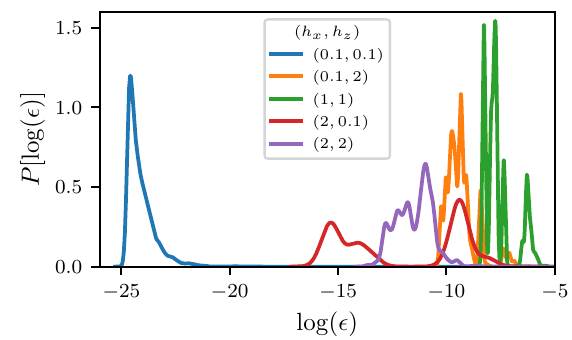
FIG. 4. Probability distribution function P [log ((cid:3)) ] of QAOA outcomes on 10 000 uniformly generated initial angles having as target the ground state of the points in S . Data are for system size N = 8 and p = 4, with the protocol in Eqs. (13)–(11).